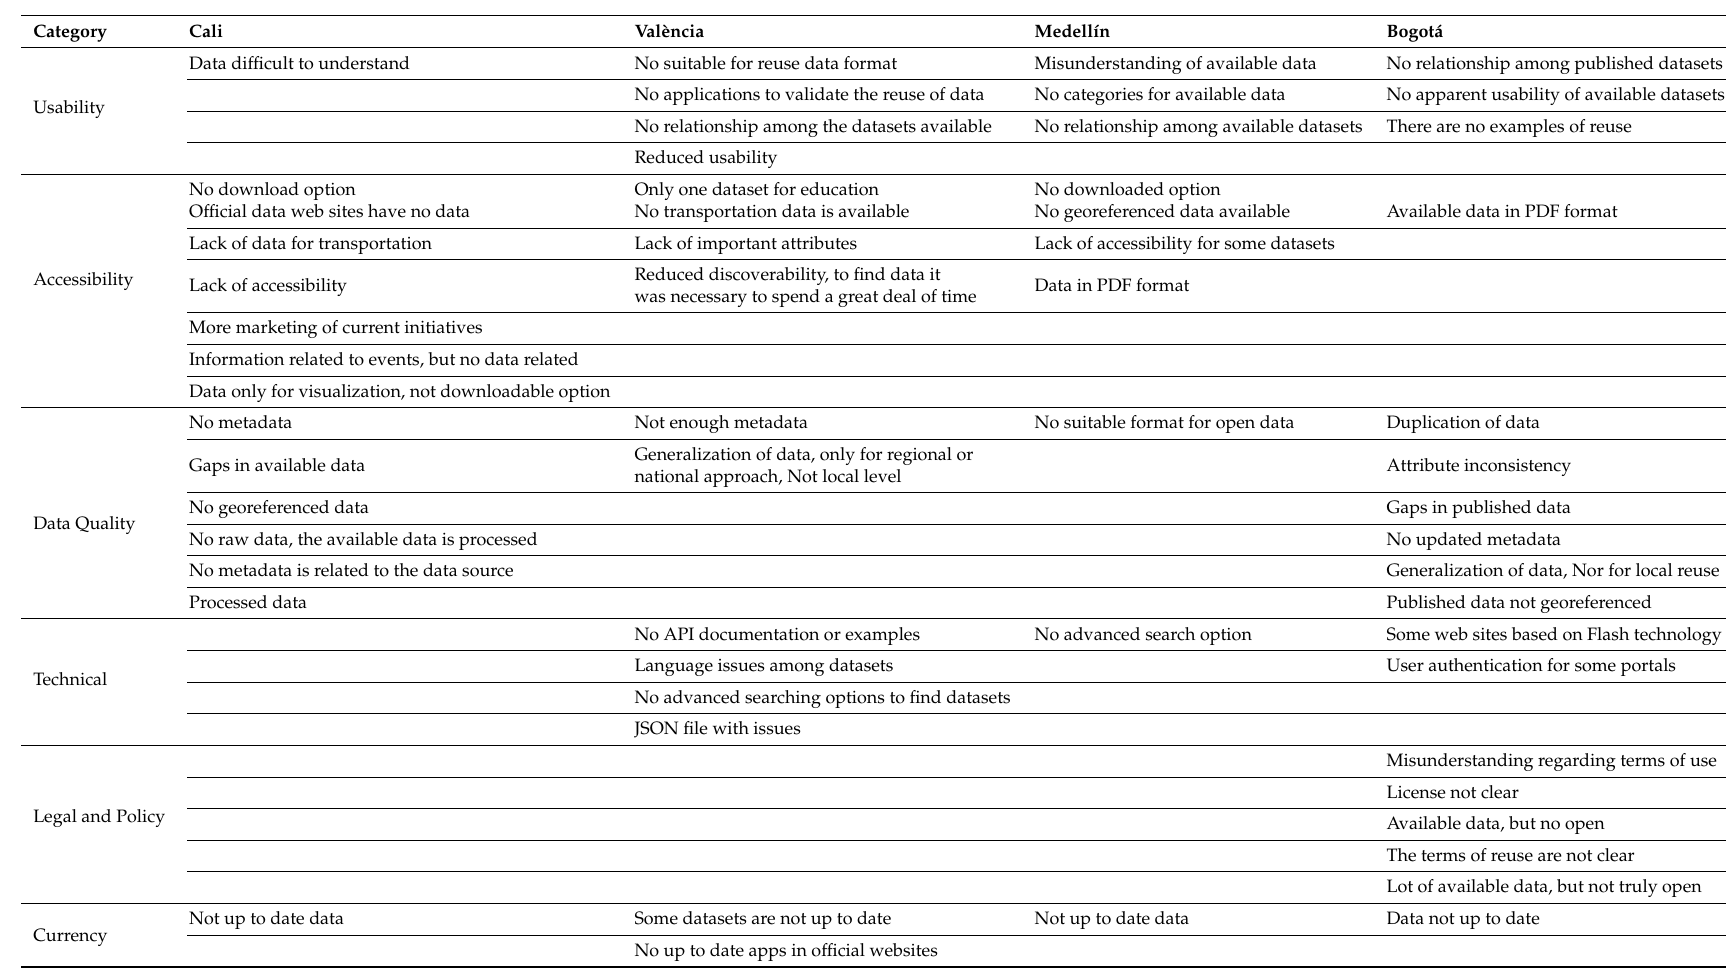
Table 8. Most mentioned barriers by data users in selected cities in the participatory